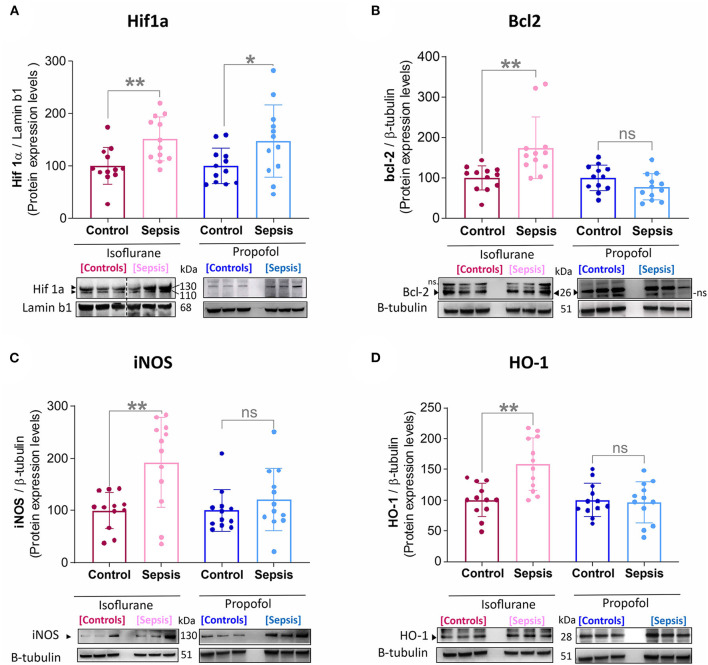
Effect of Sepsis with Isoflurane or Propofol anesthesia on Liver HIF1a, Bcl2, iNOS and HO-1, Protein expression levels. (A) HIF-1α protein was increased in both anesthetic groups by sepsis (Isoflurane +Sepsis, **p = 0.004 and Propofol + Sepsis, *p = 0.04). (B) Bcl-2 protein was increased in Isoflurane +Sepsis group (**p = 0.004) and no significant change in Propofol + Sepsis (*p = 0.104). (C) Inducible nitric oxide synthase [iNOS, (**p = 0.002)] and (D) Heme oxygenase-1 (HO-1, ***p = 0.0006) was increased in Isoflurane +Sepsis group. Whereas, in animals anesthetized with Propofol, three organ-protective proteins, Bcl-2, iNOS, and HO-1 expression was unchanged significantly. Data are shown in mean ± S.D, n = 12. *denotes a statistically significant (P ⩽ 0.05) difference between animals exposed to sepsis and controls. Statistical differences between results were evaluated using the t-test. “ns” (in graphs) represents not statistically significant. “ns” (in immunoblots) represents non-specific signal. “◂” represents specific signal.